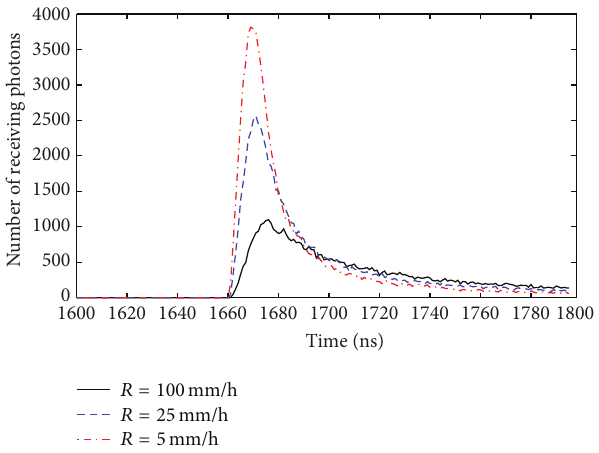
Figure 3: Temporal profiles of transmitted laser pulse for variable rainfall rates.